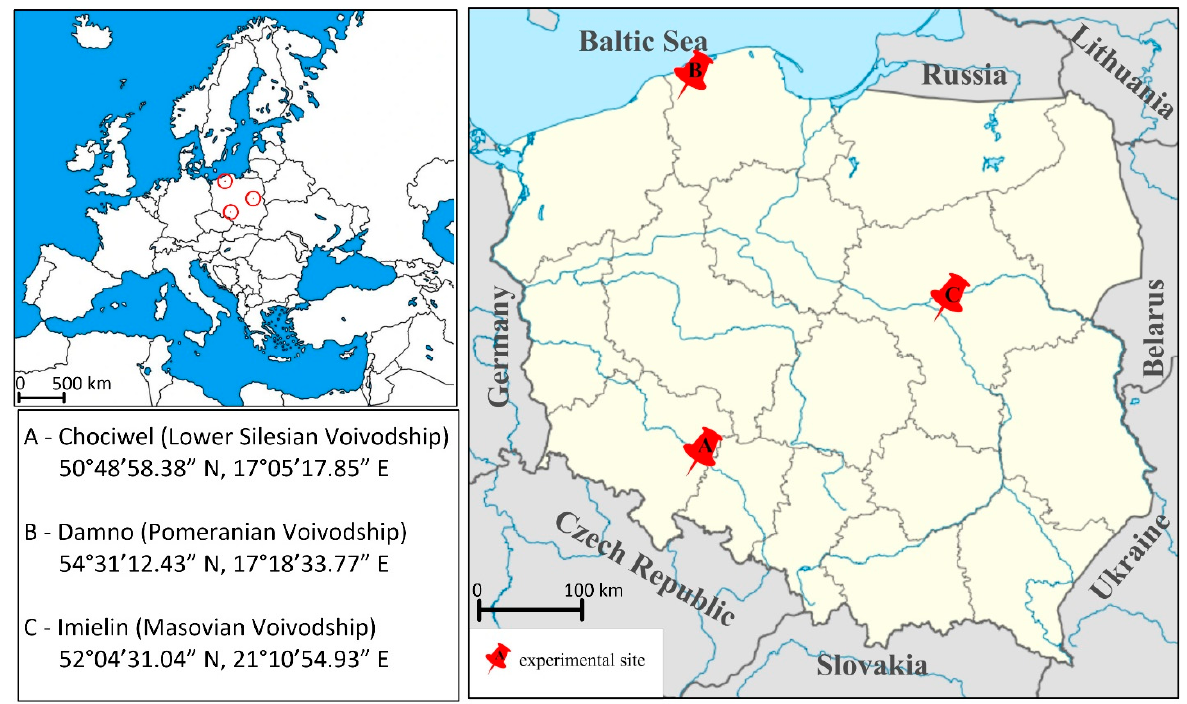
Figure 2. Locations of experimental sites.